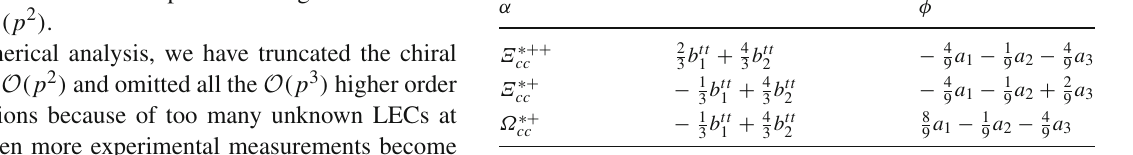
Table 6 The coefficients of the loop corrections to the spin- 3 LECs b 1 , 2 in the table represent b tt